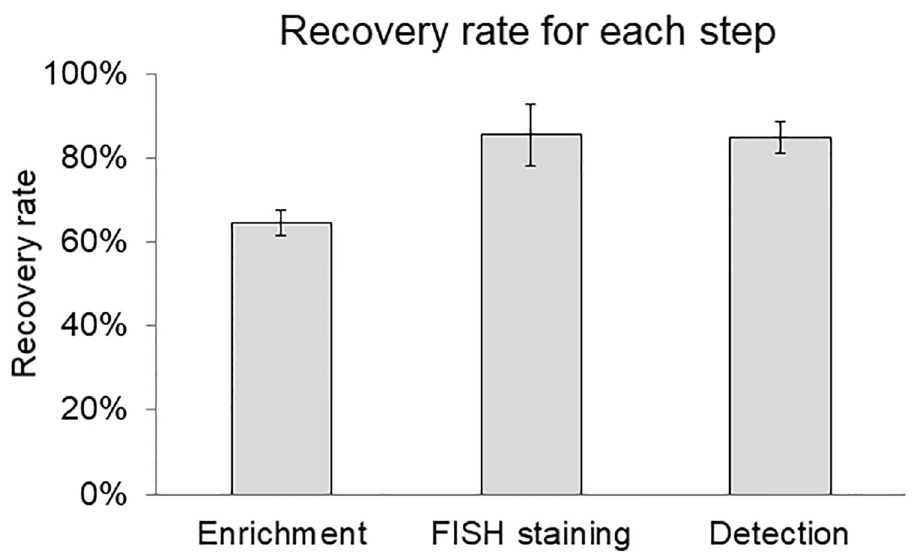
Fig 5. Recovery rates in each step of the CTC detection system. CellHunt dye-stained SK-BR-3 (150 cells) were spiked into 7.5 mL of whole blood and evaluated for recovery rate in each step of the process (n = 3). Data are presented as mean ± 1 SD. https://doi.org/10.6084/m9.figshare.12433493.v1.